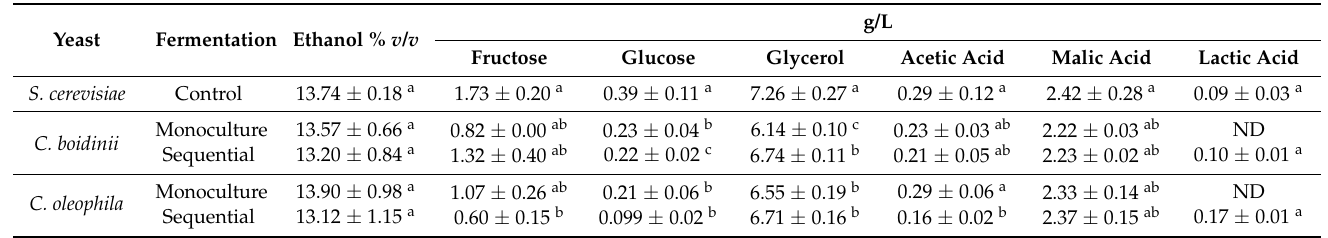
Table 6. Composition of Sauvignon Blanc wine obtained by microvinification with grapes from the Casablanca Valley (Valpara í so, Chile).